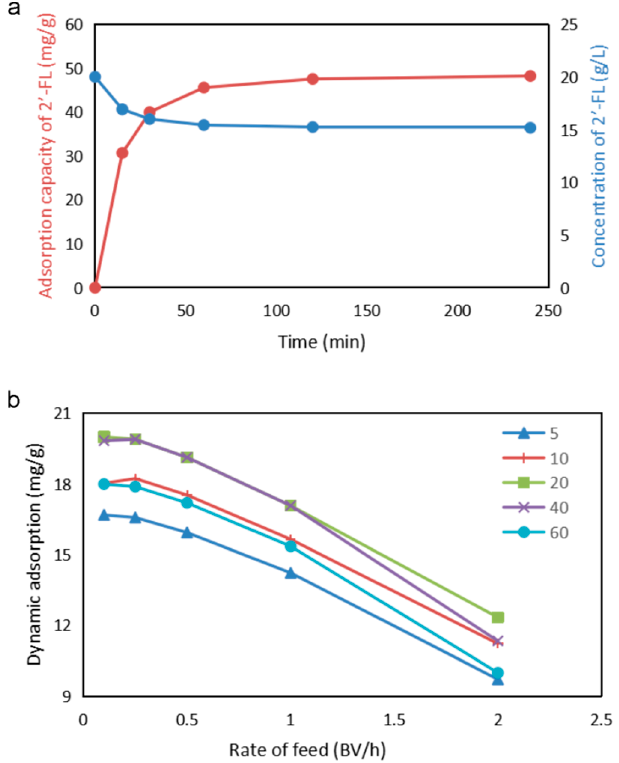
Figure 6. Static adsorption and dynamic adsorption results of activated carbon. ( a ) Static adsorption; ( b ) dynamic adsorption on the feed concentration of 2 ′ -FL with 10 g/L.